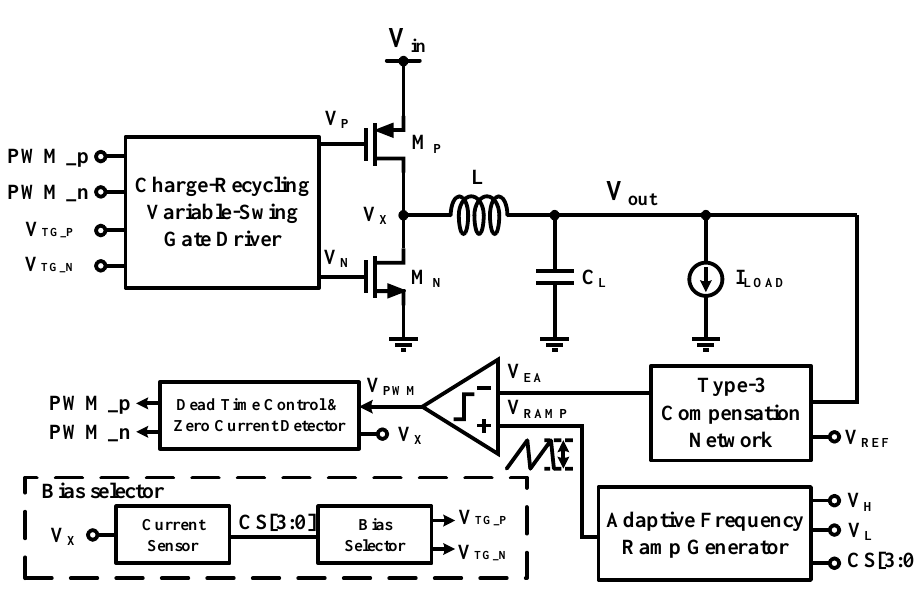
Figure 1. Proposed PWM buck converter with charge-recycling variable-swing gate driver.